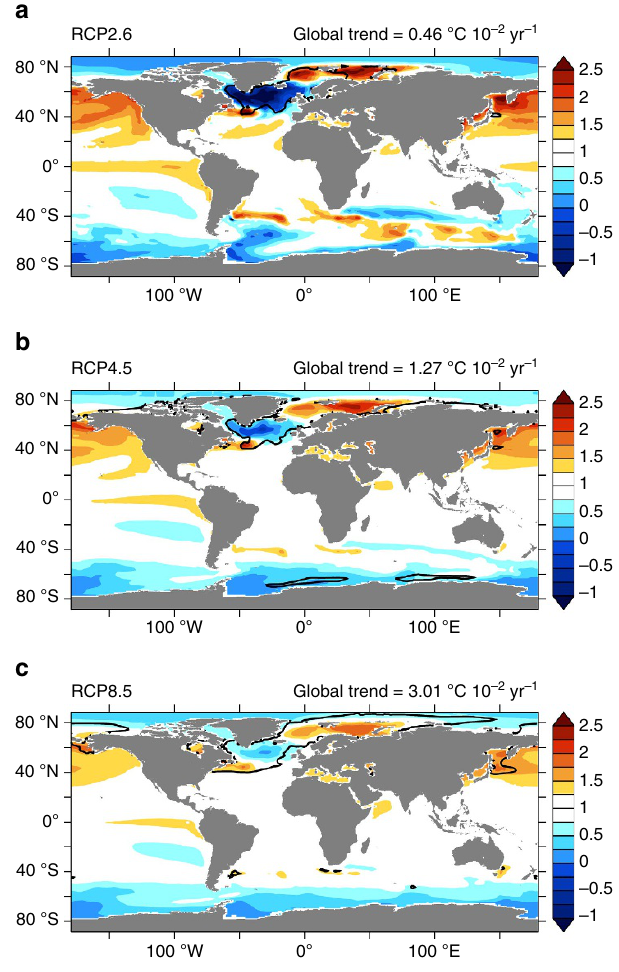
Figure 2 | Patterns of SST response in RCP scenarios. Ensemble mean of the 21st century SST trend normalized by its own global mean (dimensionless quantity) for ( a ) RCP2.6 simulations, ( b ) RCP4.5 simulations and ( c ) RCP8.5 simulations. The globally averaged SST trend ensemble mean is indicated for each scenario, that is, 0.46 10 (cid:3) 2o Cyear (cid:3) 1 for the RCP2.6 experiments, 1.27 10 (cid:3) 2o Cyear (cid:3) 1 for the RCP4.5 experiments and 3.01 10 (cid:3) 2o Cyear (cid:3) 1 for the RCP8.5 experiments. Since the globally averaged SST trend ensemble mean is positive for all scenarios, the non-dimensional value in each grid point is 4 1 when characterized by amplified warming, o 1 when characterized by a subdued warming and o 0 when characterized by cooling. The black contour shows regions with maximum ensemble spread (see